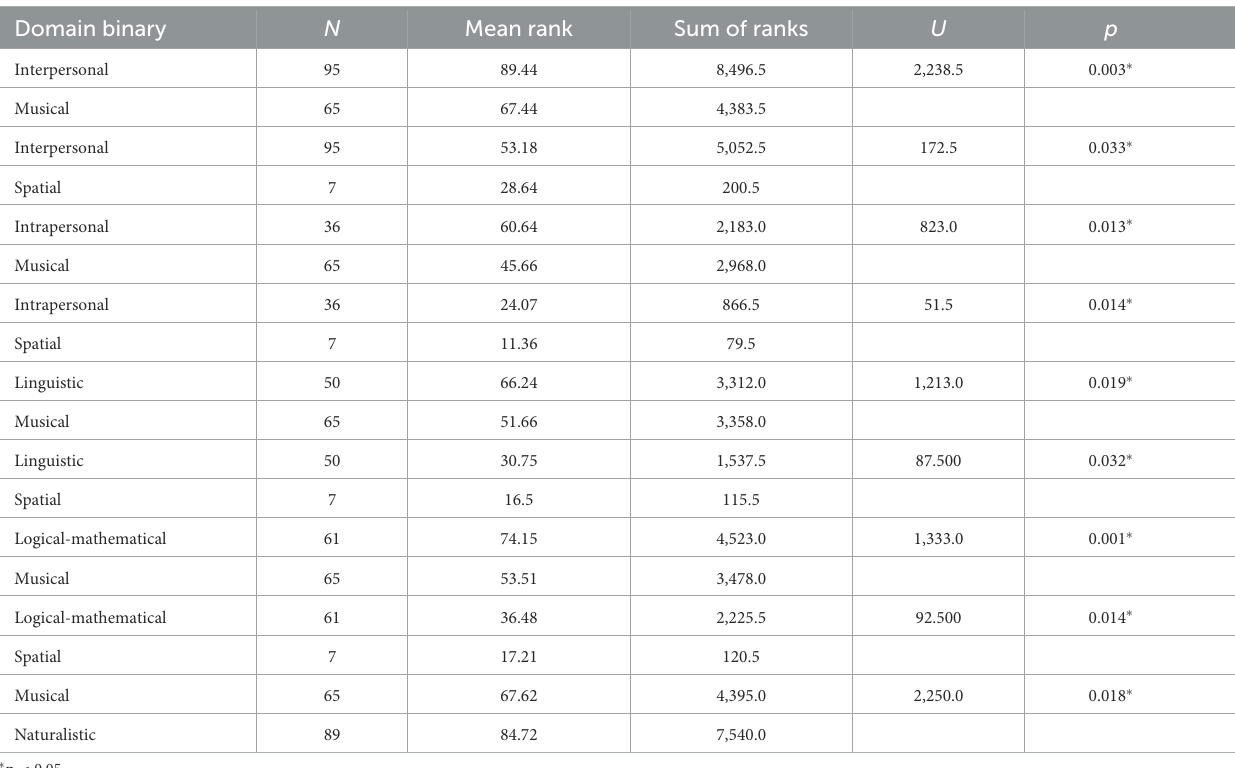
TABLE 7 Pairwise comparisons of the reflection and awareness subscale scores of university students obtained from the twenty-first-century skills scale by the self perceived intelligence types. Domain binary N Mean rank Sum of ranks U p